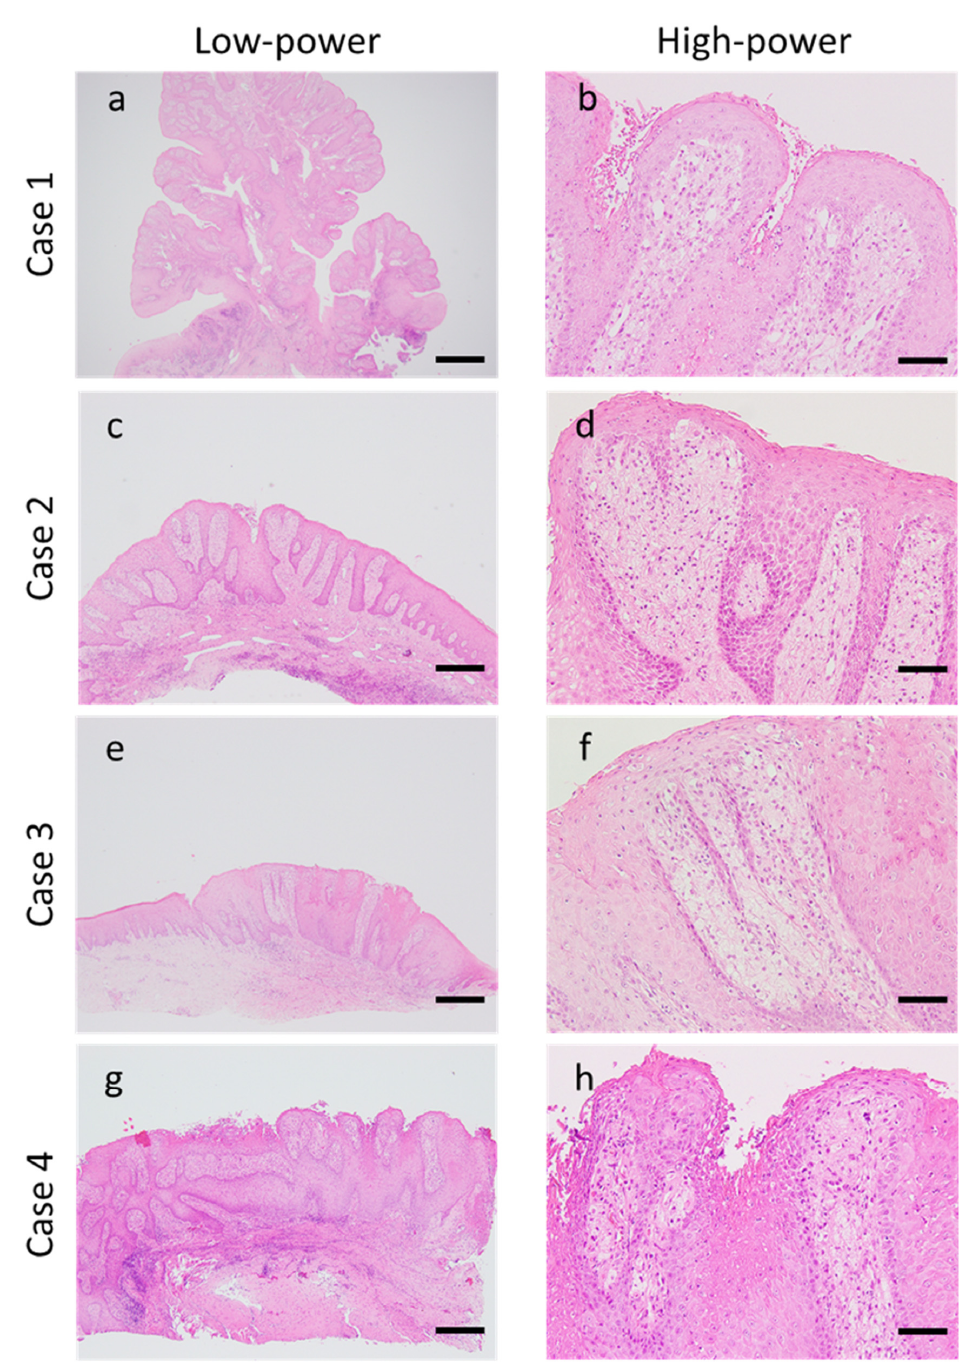
Figure 1. Morphological findings of oral verruciform xanthoma. Epithelial acanthosis with no atypia was observed in all patients with oral verruciform xanthomas (OVXs). ( a , c , e , g ) Chronic inflammatory cell infiltration into the connective tissue was observed. ( b , d , f , h ) Several foamy cells were accumulated in the connective tissue papillae. Case 1 exhibited verrucous-type OVX (( a ): scale bar, 500 μ m; original magnification, 20×; ( b ): scale bar, 50 μ m; original magnification, 200×). Case 2–4 exhibited flat-type OVX (( c , e , g ): scale bar; 200 μ m, original magnification: 40×, ( d , f , h ): scale bar; 50 μ m, original magnification; 200×).